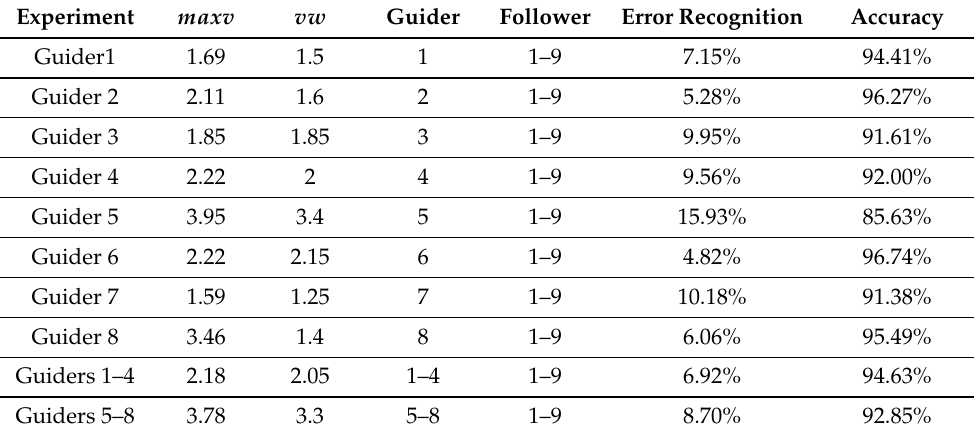
Table 6. Performance with different action fingerprint library.